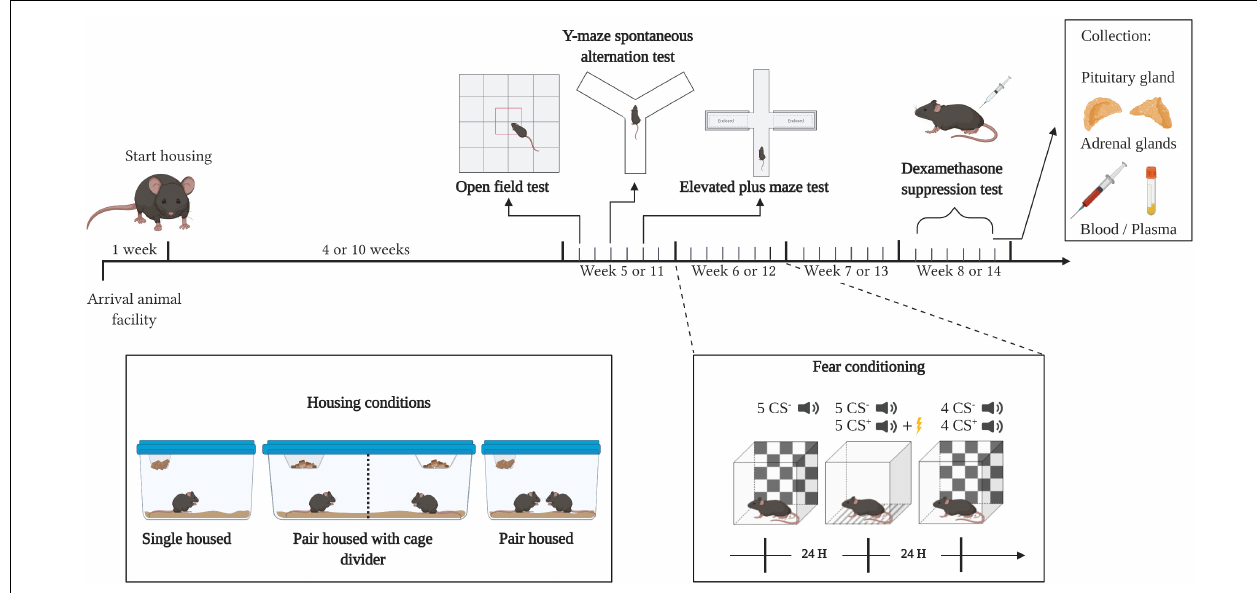
FIGURE 1 | Experimental design. Mice were housed in their respective housing conditions throughout the entire experiment. After four (experiment 1) or ten (experiment 2) weeks of housing, an open field test, Y-maze spontaneous alternation and elevated plus maze test were performed. The next week, mice were subjected to an auditory fear conditioning procedure, and 2 weeks later, mice were subjected to the dexamethasone suppression test, after which they were sacrificed, and plasma, the adrenal glands and pituitary gland were harvested. Starting after the housing period, each area between black (big) indentations represents a week, while each area between gray (small) indentations represents a day. CS − ,generalization cue; CS + , conditioning cue; H, hour. Created with BioRender.com.